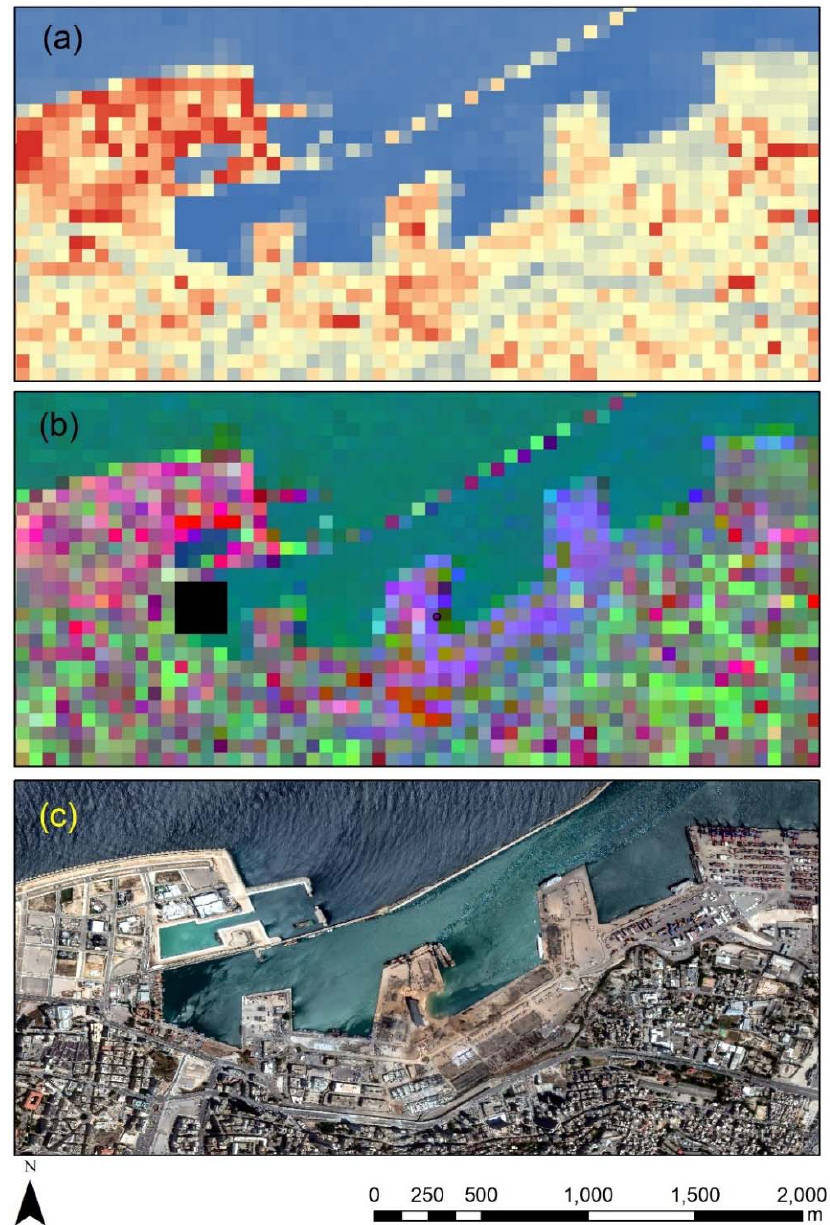
Figure 10. ( a ) The first principal component (PC1) results over the area around the harbor after the Principal Component Analysis (PCA) of the integrated Sentinel ‐ 2 optical images of 24th of July 2020 and 8th of August. ( b ) The PC1–PC3 pseudo color composite of the same integrated dataset and ( c ) the high ‐ resolution WorldView ‐ 2